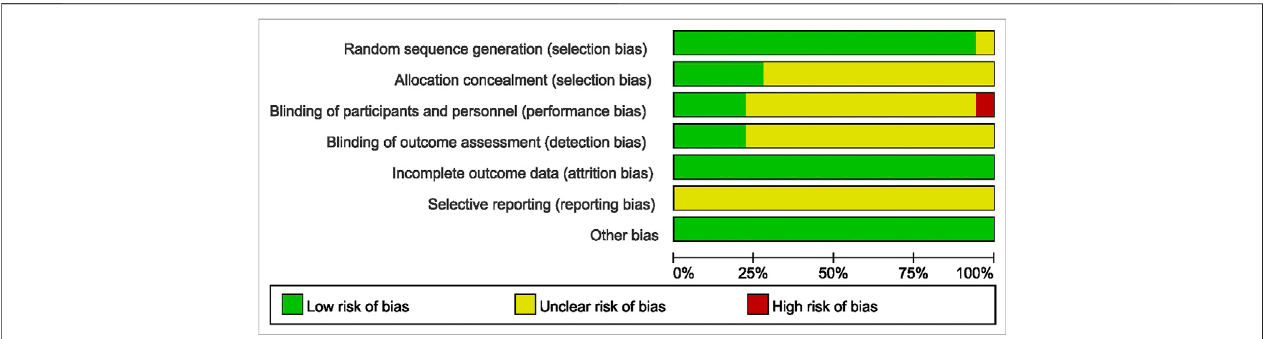
FIGURE 2 | Risk of bias